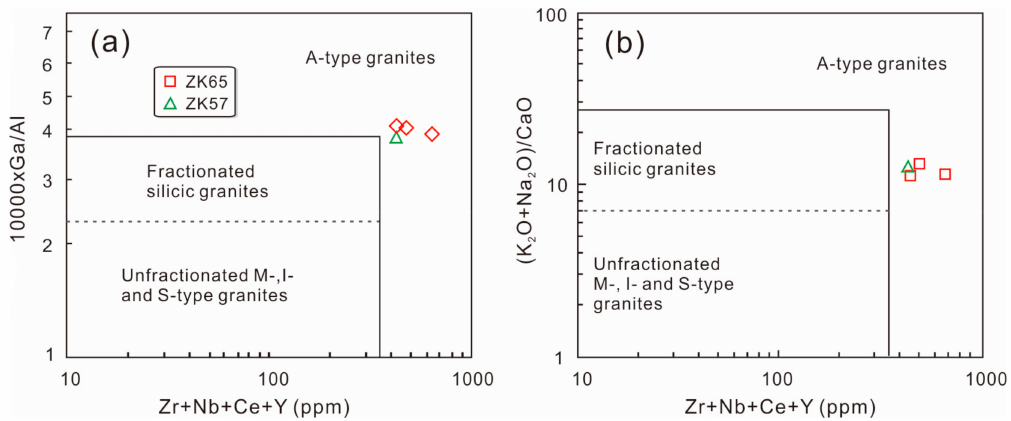
Figure 6. ( a ) 10,000 × Ga/Al and; ( b ) (K 2 O + Na 2 O)/CaO vs. Zr + Nb + Ce + Y (ppm) diagrams showing that the Jurassic low Sr and high Yb granites are A-type granites [59].